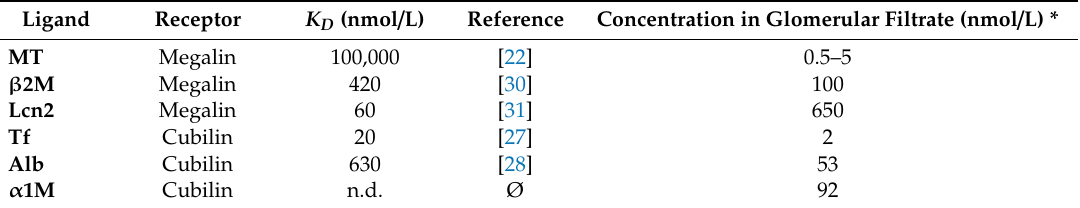
Table 1. Binding a ffi nities and estimated concentrations of ligands of megalin and cubilin in the renal glomerular filtrate.